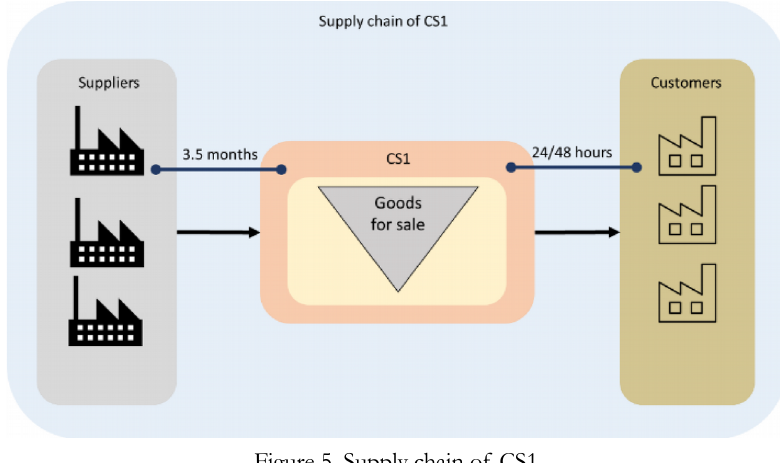
Figure 5. Supply chain of